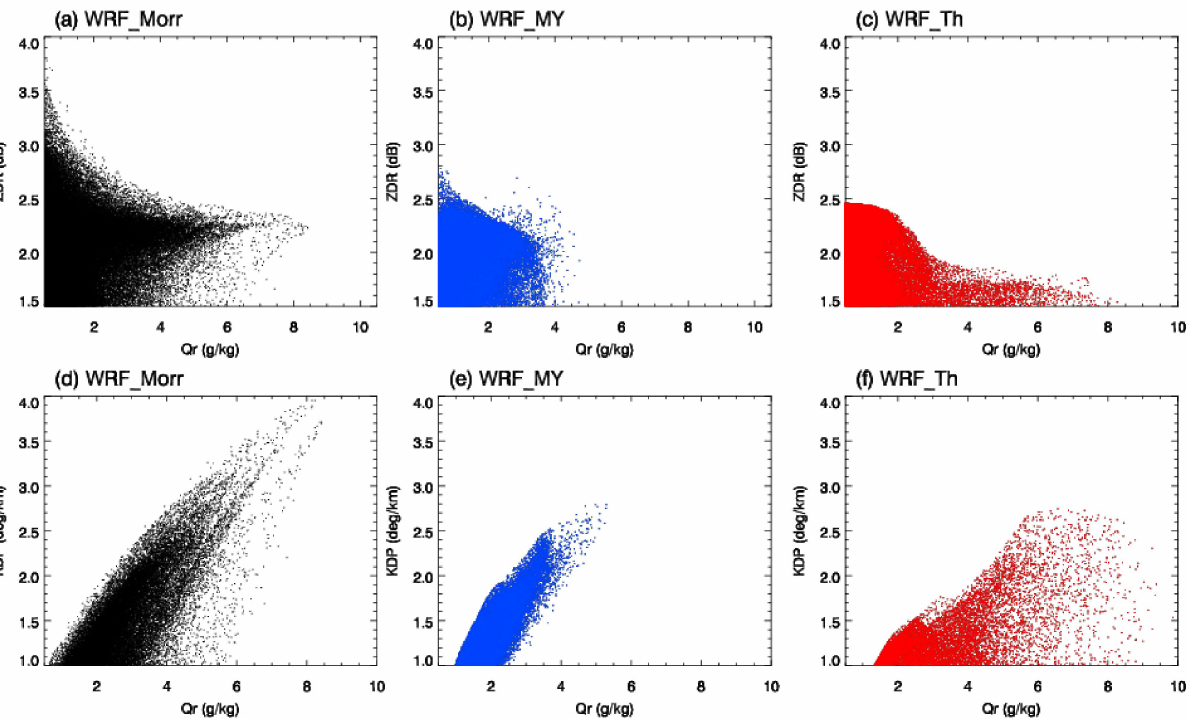
Figure 14. Scatterplots of large Z DR vs. q r in ( a – c ) and K DP vs. q r in ( d – f ) for WRF_Morr, WRF_MY, and WRF_Th, respectively, when temperature was equal to or above 0 ◦